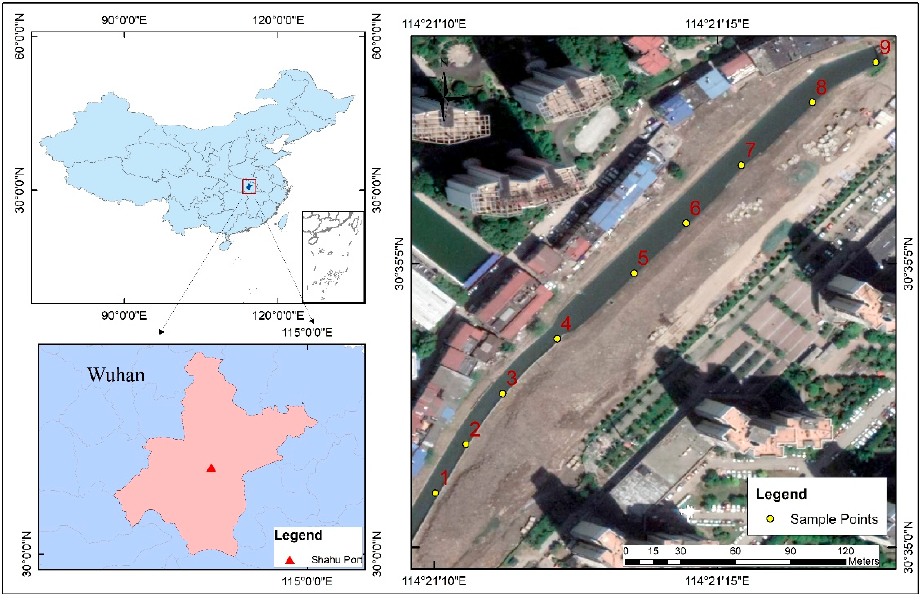
Figure 2. Sampling sites at the polluted riverway Shahu Port (SP) in Wuhan.